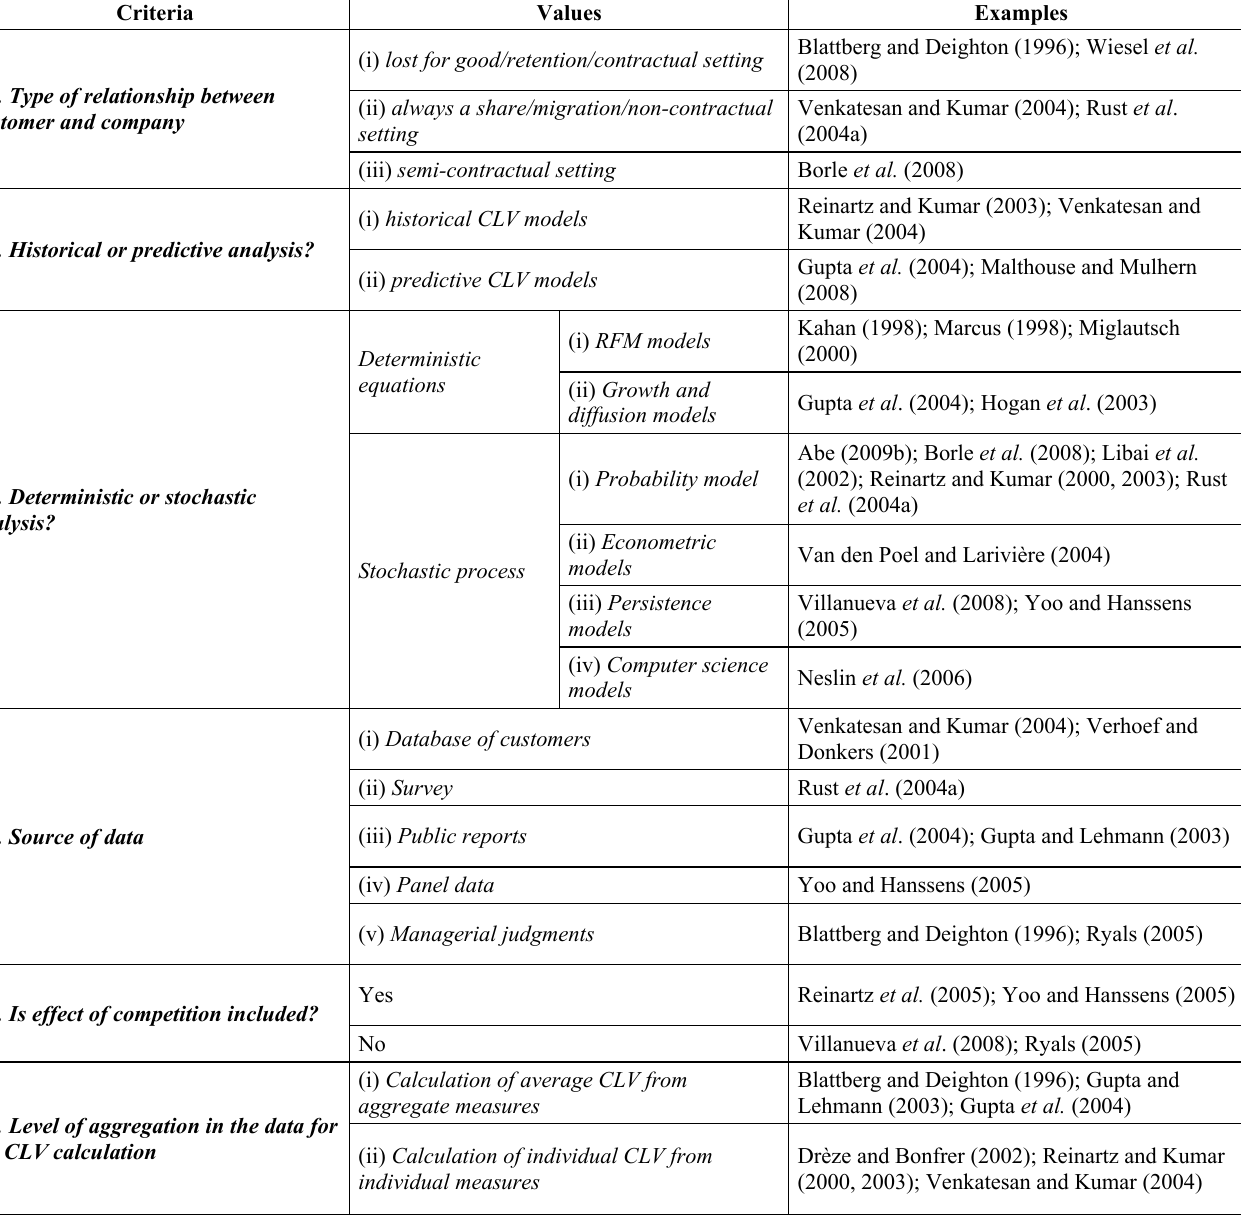
Table 4: Summary of the CLV and CE models classification